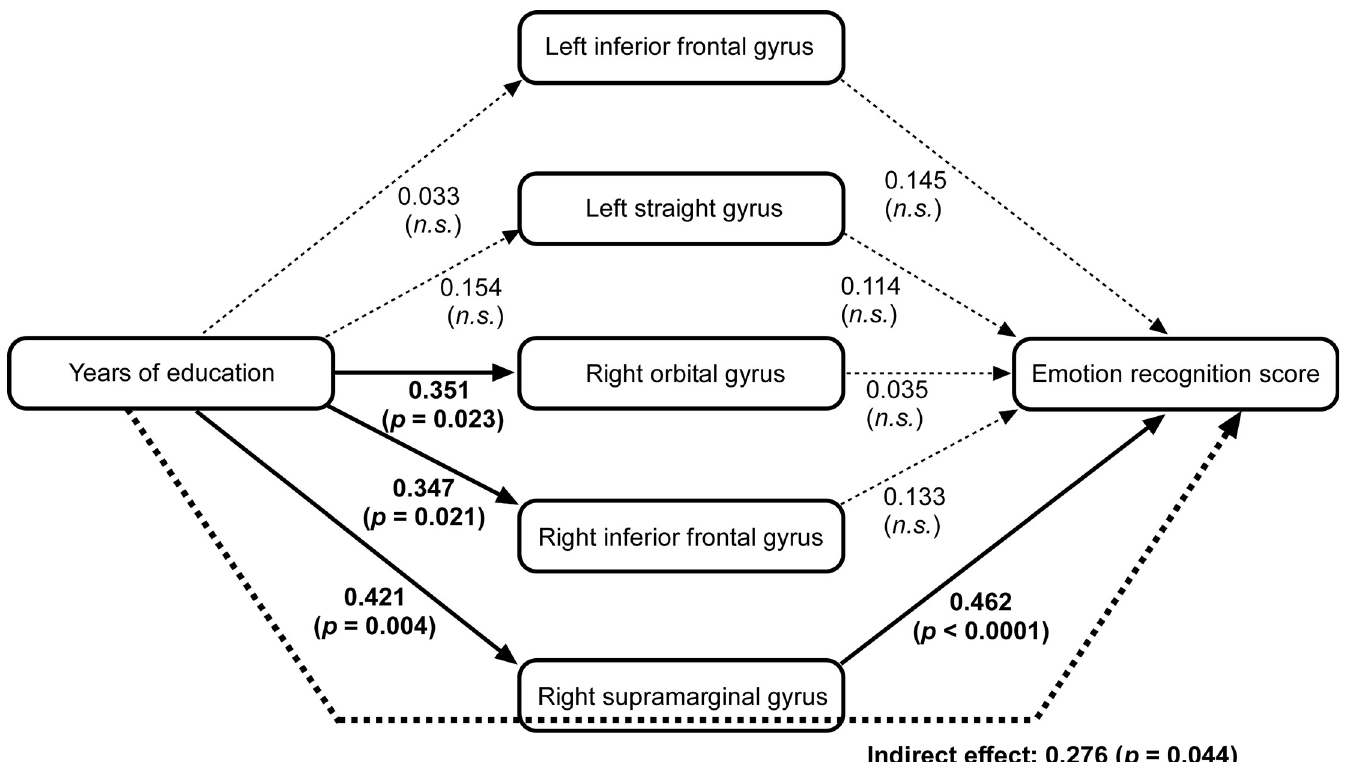
Fig 2. Path diagram. The 5 regions, years of education, and emotion recognition score were set as the observed variables. The solid lines indicate a significant direct effect. The dotted thick line indicates a significant indirect effect. Thin dotted lines indicate a non-significant direct path. Numbers indicate the standardized path